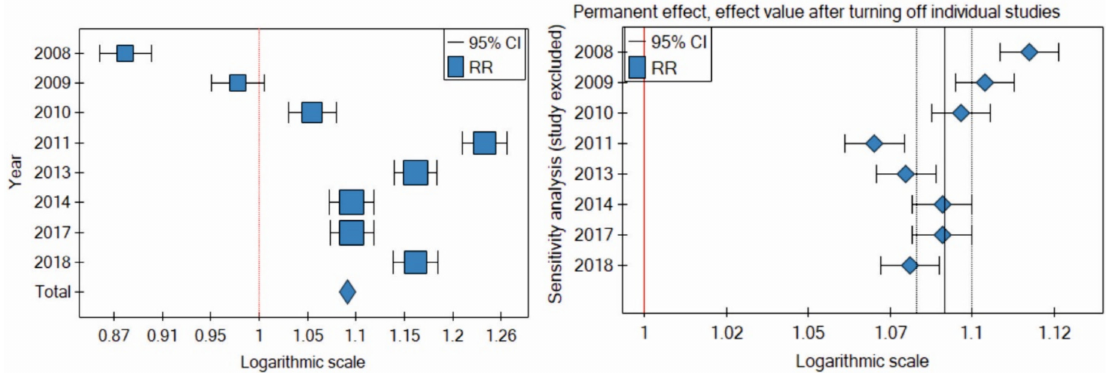
Figure 7. The relative risk of an accident at work among workers aged 55–59 employed in Poland (own elaboration).